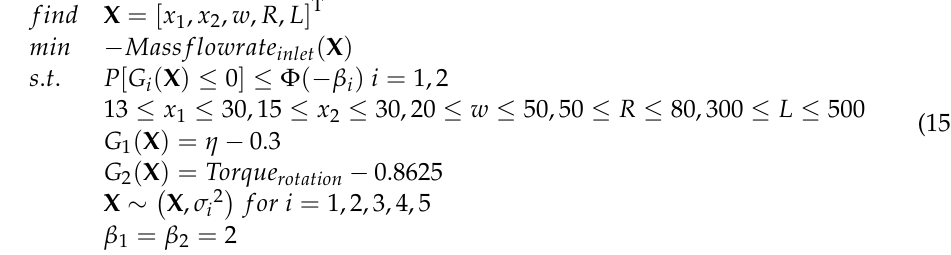
Table 9. Information of the random design variables of the cooling fan. Variable PDF. Standard Deviation σ x 1 Normal 0.01 x 2 Normal 0.01 w Normal 0.03 R Normal 0.5 L Normal 0.02